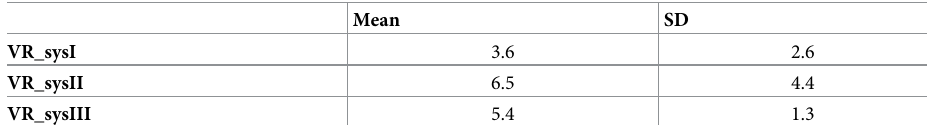
Table 11. Descriptive statistics for Q15.